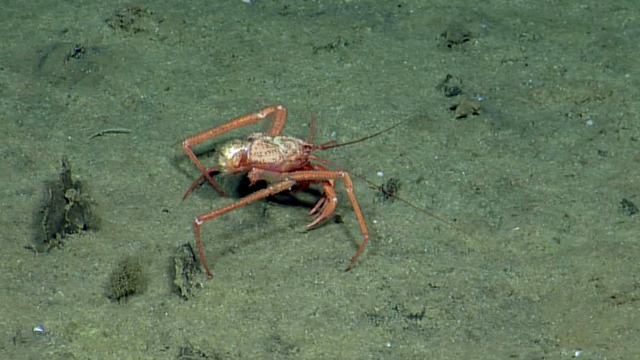

Probeebei
mirabilis